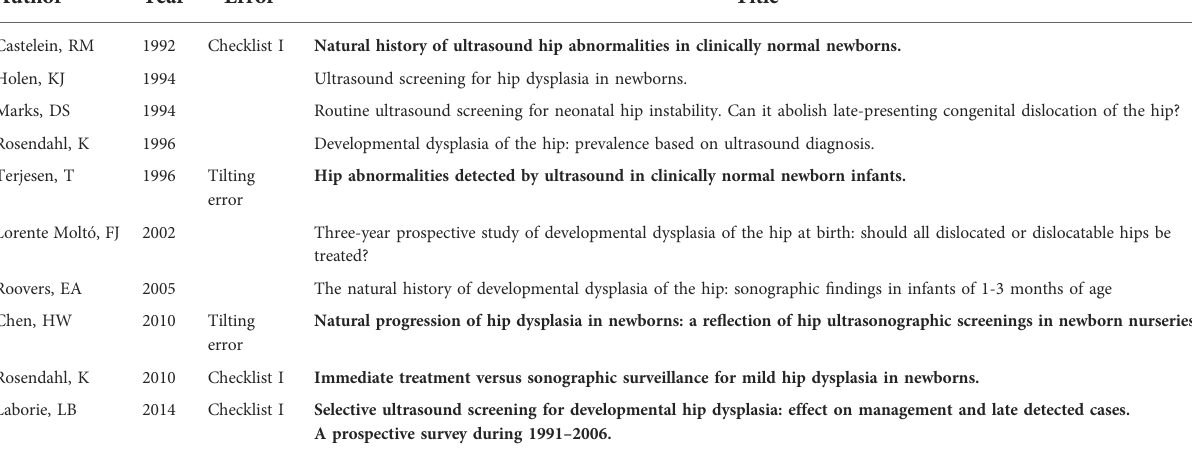
TABLE 1 Overview on fi nal 10 analyzed